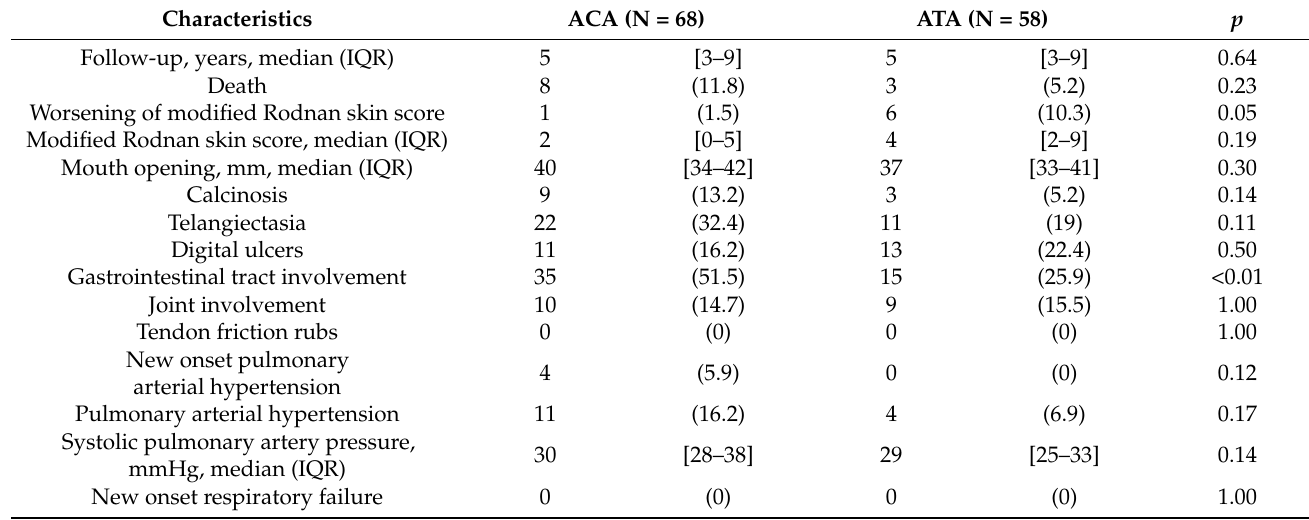
Table 5. Characteristics of patients with limited systemic sclerosis at last